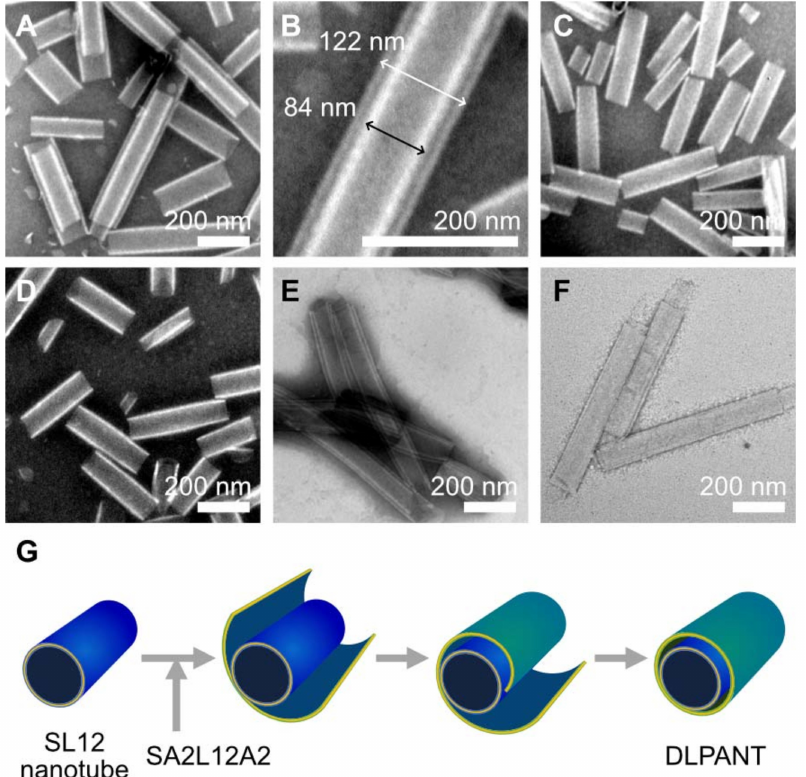
Figure 5. Negatively stained TEM images of assemblies prepared by SA2L12A2 self-assembling in a SL12 nanotube dispersion ( A , B ), SL12 self-assembling in a SA2L12A2 nanotube dispersion ( C ), and the self-assembly of a mixture of SL12 and SA2L12A2 ( D ). ( B ) is the magnification of ( A ). TEM observation of SA2L12A2 self-assembled on the surface SL12 nanotubes with 30% PEG ( E ) and subsequent purification to remove PEG through dialysis ( F ). Schematic illustration of the formation mechanism of DLPANT ( G ). Scale bars are 200